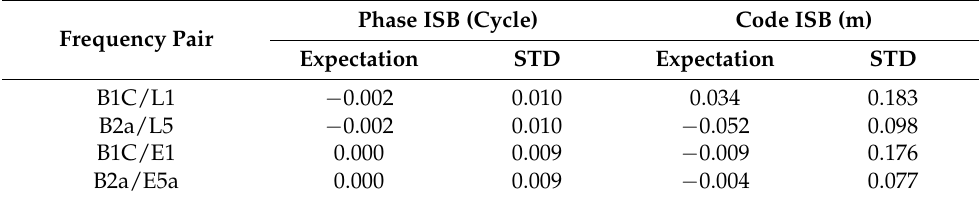
Figure 4. Inter-system bias (ISB) time series of both phase and code observations between BDS-3 and GPS/Galileo for the overlapping frequencies B1C/L1/E1 and B2a/L5/E5a. From the left to the right, B1C/L1, B2a/L5, B1C/E1, and B2a/E5a observations on DOY 120, 2021 were applied to assess the ISBs. The text in magenta describes the statistics of the ISBs. Table 4. Mean value and Standard Deviation (STD) of short-term